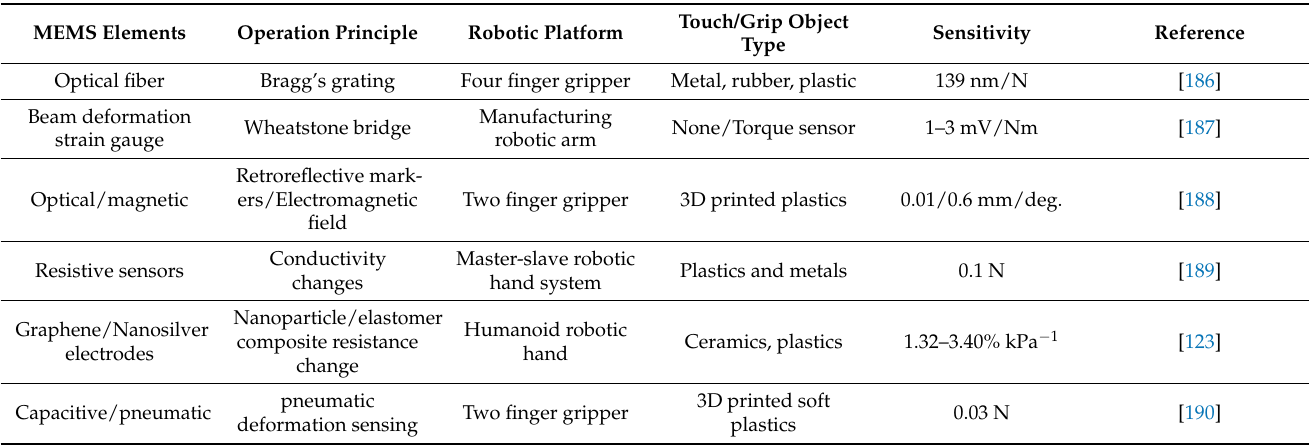
Table 9. Selected examples of MEMS-based sensors for object griping and recognition on various robotic